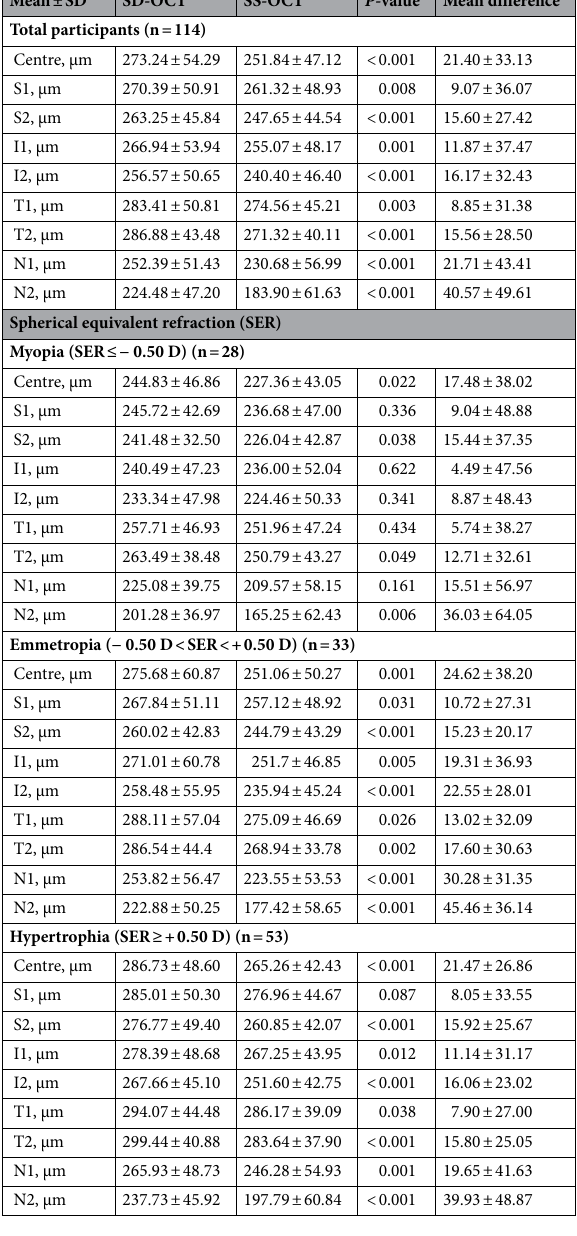
Table 2. Comparison of choroidal thickness measurements between spectral-domain optical coherence tomography (SD-OCT) and swept-source optical coherence tomography (SS-OCT) in general and subgroup analysis classified by spherical and cylindrical power. SD, standard deviation; SD-OCT, spectral-domain optical coherence tomography; SS-OCT, swept-source optical coherence tomography; Centre, central